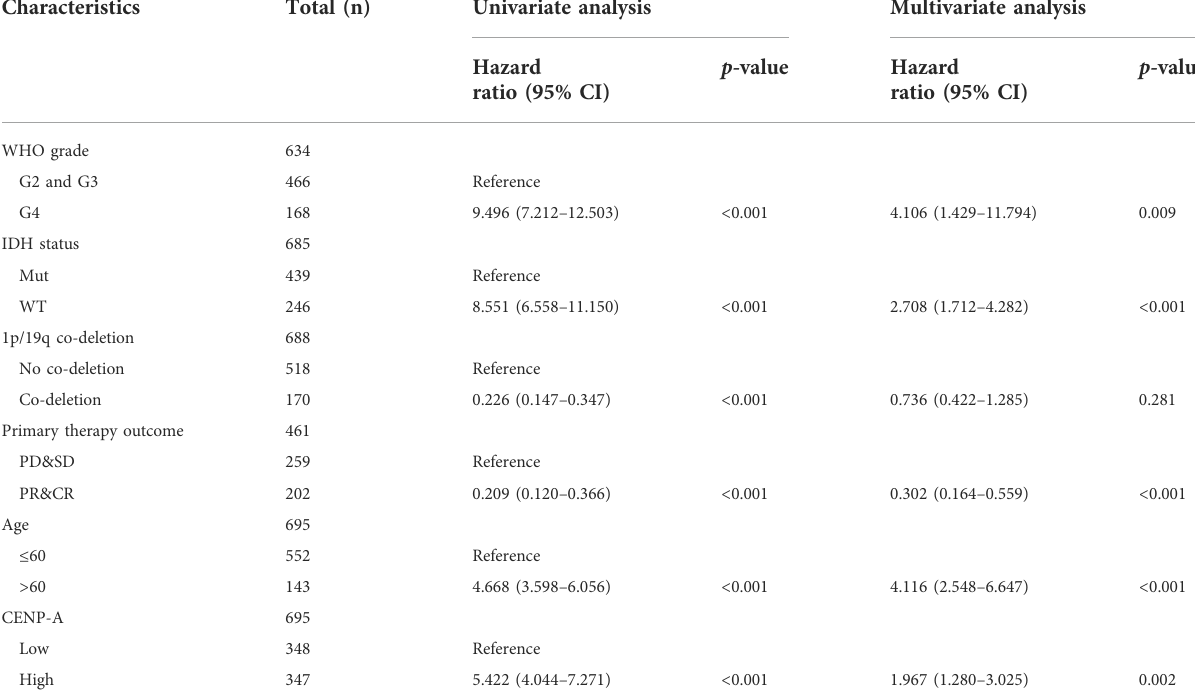
TABLE 3 The correlation of CENP-A and clinicopathologic characteristics with overall survival in patients with glioma in TCGA, and the multivariate survival model based on univariate selection (Cox regression).